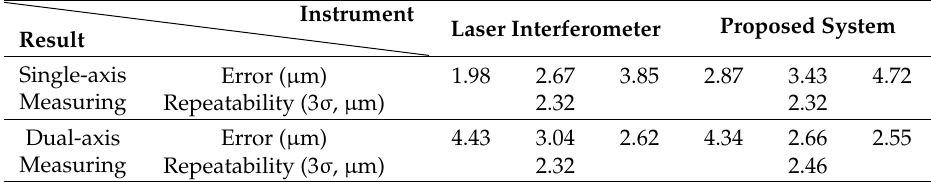
Figure 15. Repeatability of dual-axis measurement verification. Table 4. Verification of vertical straightness measurements.